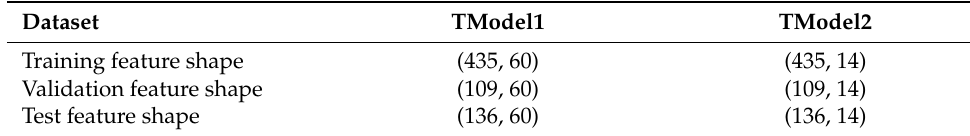
Table 7. TensorFlow Training Model Shapes.